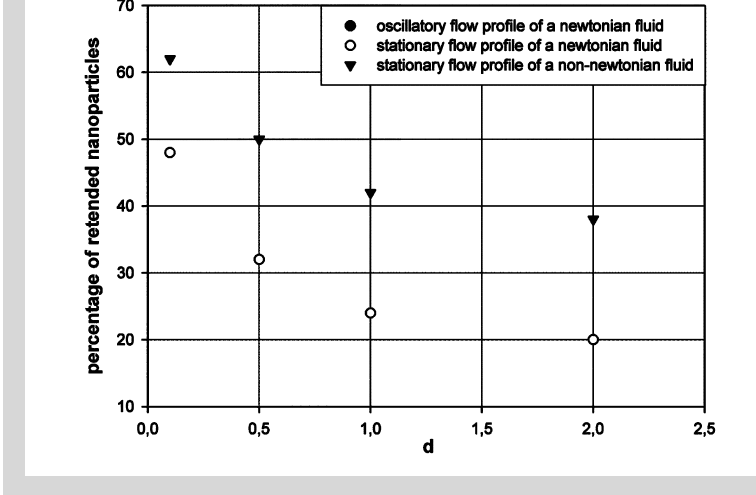
Figure 6: Fraction of retained nanoparticles in relation to the distance, d, between field sources and vessel for different flow